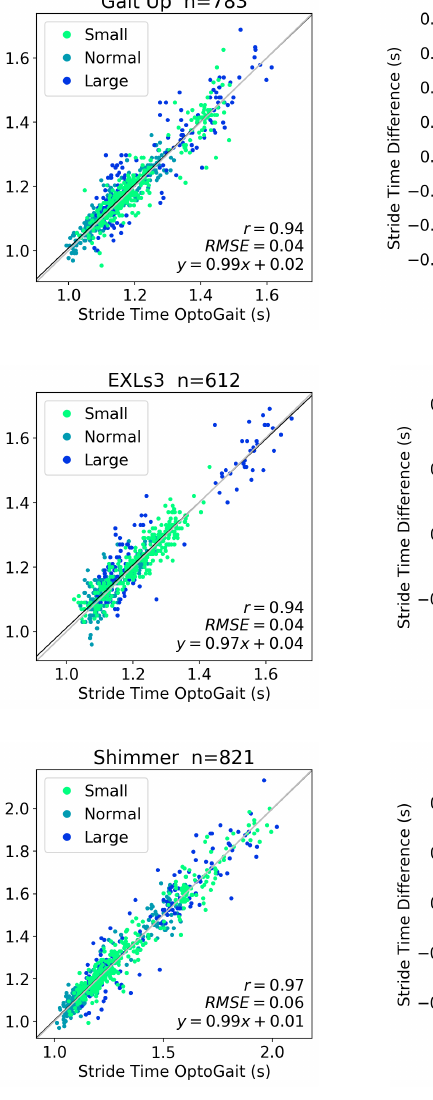
Figure A2. Correlation analysis and Bland–Altman plots of stride times from IMU and OptoGait. r: correlation coefficient, RMSE: root mean square error, LoA: average limits of agreement at ± 1.96 standard